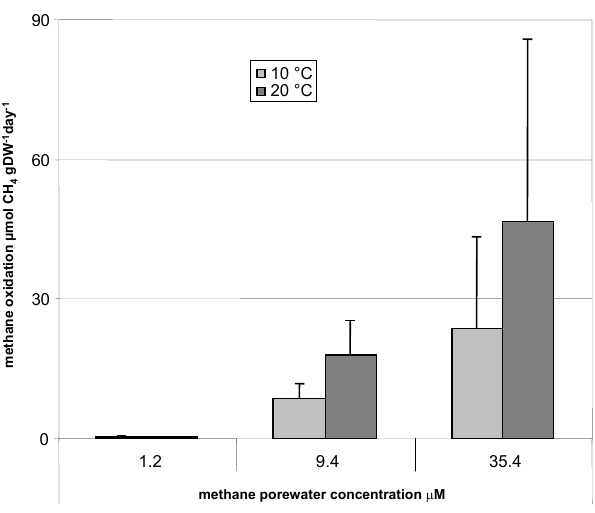
Fig. 1. Methane oxidation activities plotted against different methane pore water concentrations of the pool samples “high CH 4 ” bog. Activities were measured at two different temperatures: 10 and 20 ◦ C.